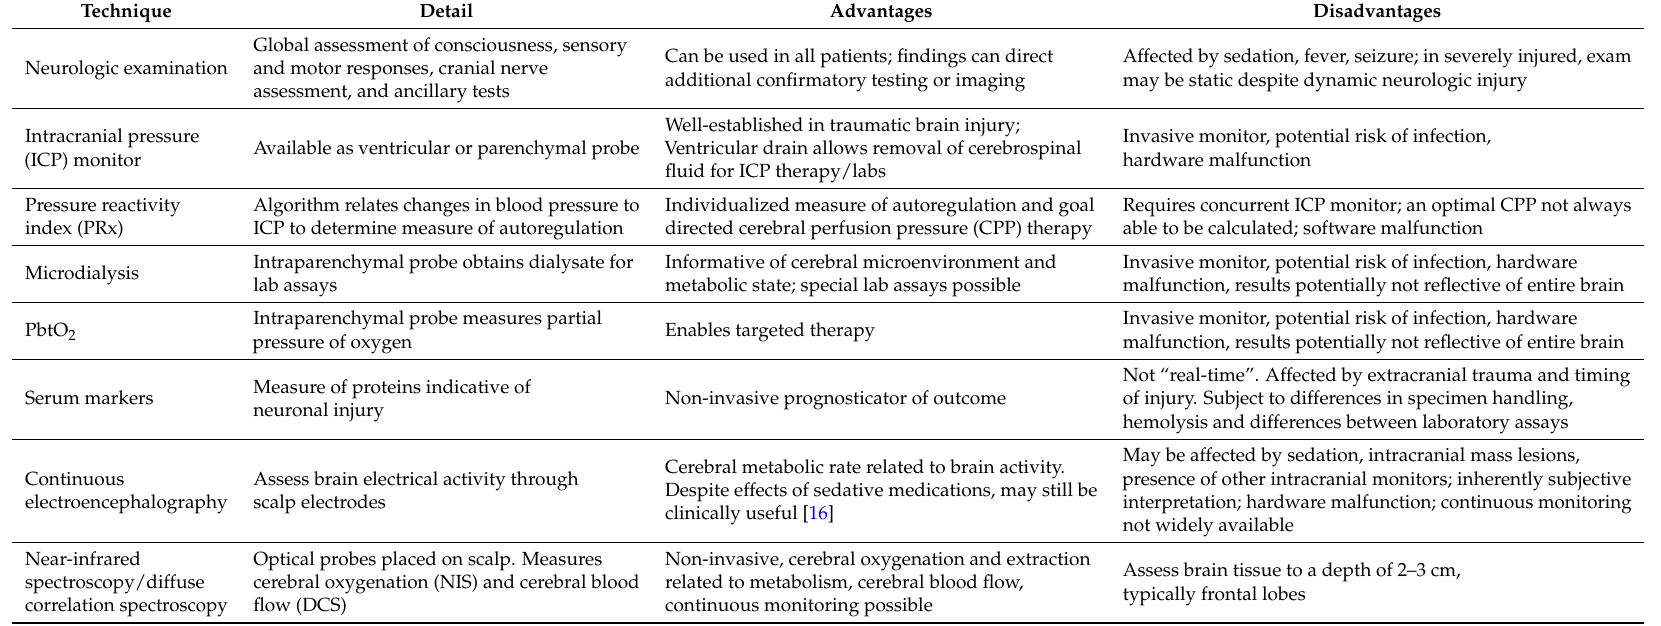
Table 1. Techniques for brain